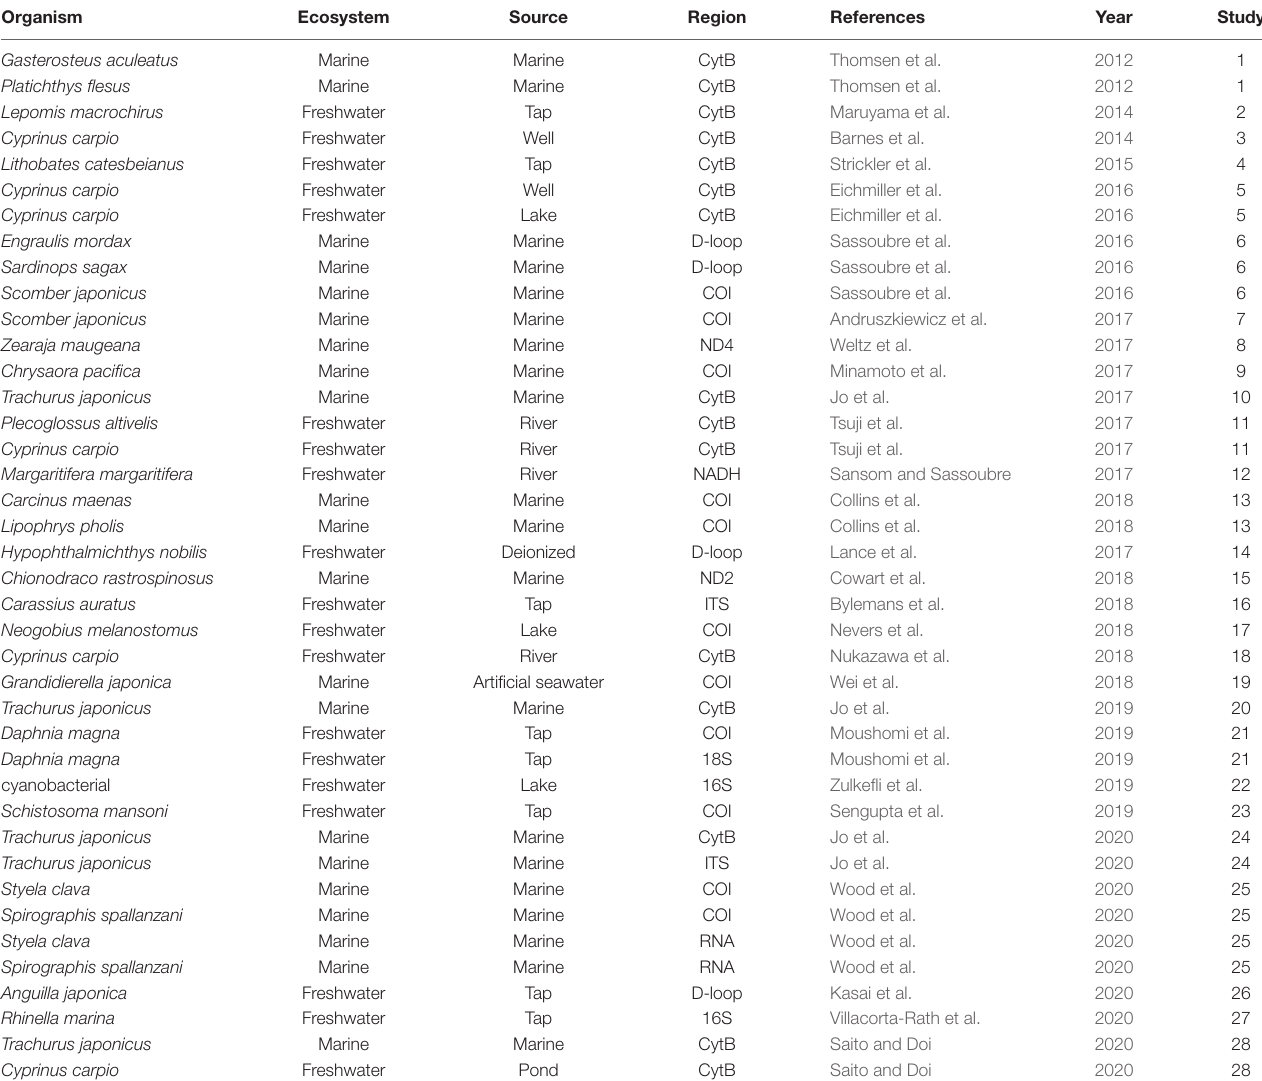
TABLE 1 | The organisms, ecosystem types (Ecosystem), water source (Source), and PCR-amplified DNA regions by quantitative PCR (Region) for all papers analyzed in this meta-analysis.